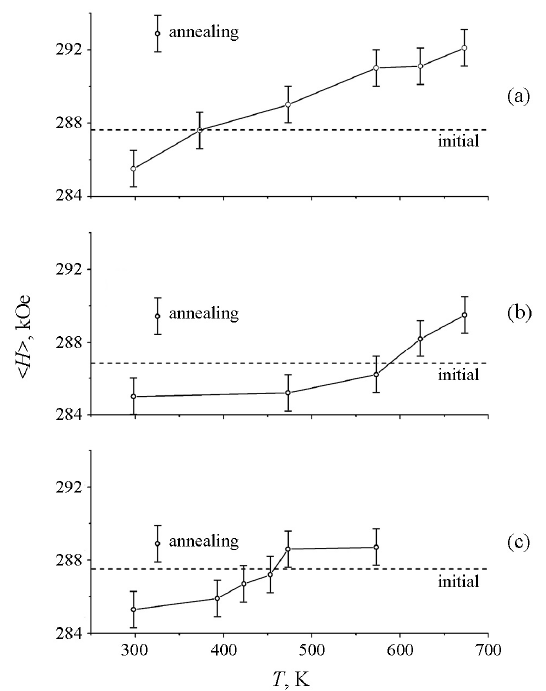
Figure 4. Dependence of < H > on the temperature of deformation of alloys: ( a )—Fe ‐ 16Cr, ( b )—Fe ‐ 16Cr ‐ Sb, and ( c )—Fe ‐ 16Cr ‐ Au. Dash line designates the value of field < H > in the initial state of the alloys. Dot designates the value of < H > in the alloys after annealing at 773 K, 1 h. Table 2. Hyperfine parameters* and contributions of subspectra for the Fe ‐ 16Cr alloy. Subspectra contributions are presented for random distribution ( A theor ), initial state ( A i ) and after HPT at 298 K ( A 298 ) and 623 K ( A 623 ).